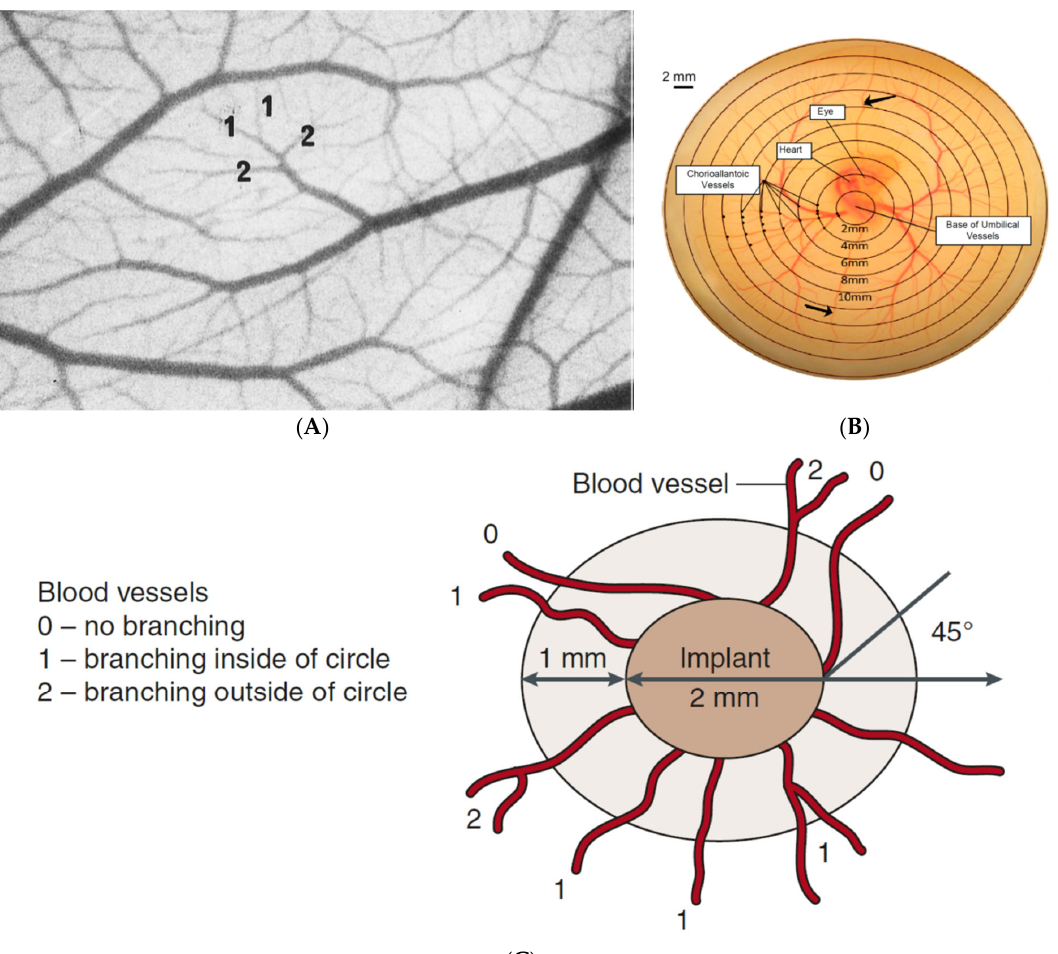
Figure 5. Examples of CAM analysis techniques to quantify angiogenic score following treatment. In the case of each of these methods, each blood vessel which fits specific criteria is given a score, with the accumulative score then determined for each on-plant/treatment. ( A ) Centripetal ordering method of angiogenic scoring, where vessels are assigned a score based on the order of their branching, with higher order vessels getting a higher score as described in DeFouw et al. [231]. ( B ) A range of concentric circles projected onto an image of a CAM where the total vascular index quantified based on the intersection of blood vessels with each of the circle, as described in Burggren et al. [230]. ( C ) Evaluation of a angiogenic response by scoring vessel branching as described by Ribatti et al. [32], this method involves the assigning of an angiogenic score ranging from 0–2 based on branching and angle of